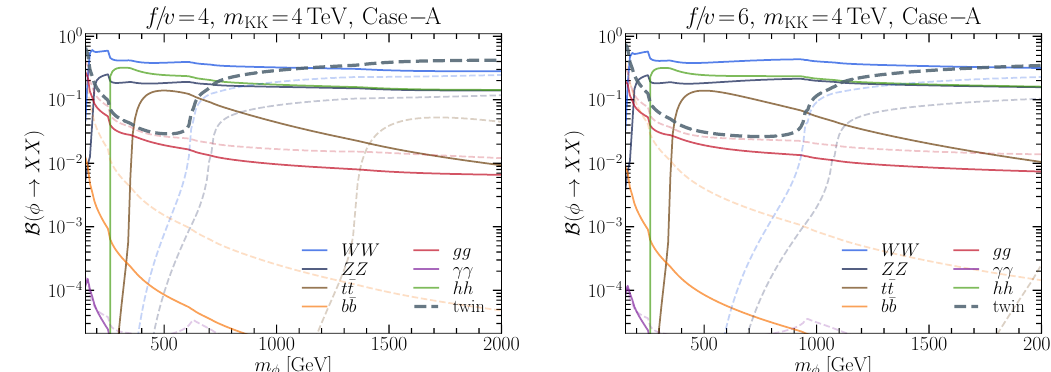
Figure 3 . Branching ratios of dilaton to the SM and twin sectors as a function of its mass for the choice of parameters f=v = 4 (left-panel), 6 (right-panel) and m KK = 4 TeV. For the anomalous contributions to massless gauge bosons we take values of b -coe(cid:14)cients for case-A. The solid curves represent the SM branching fractions, whereas, the corresponding twin curves are dashed (faded) and are summed into the gray dashed